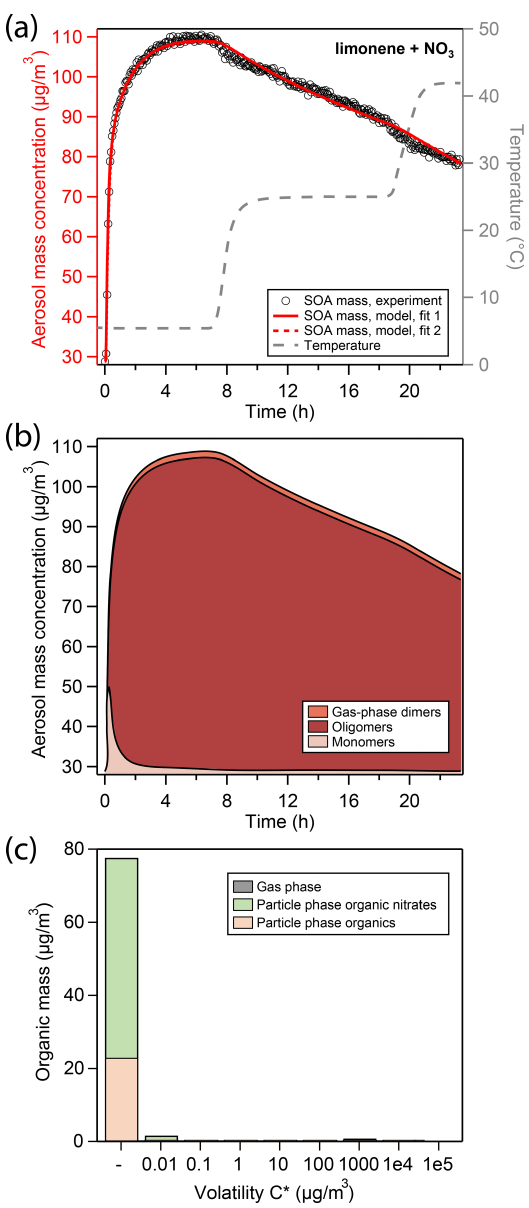
Figure 2. (a) Comparison of experimental and modeling results for oxidation of limonene with NO 3 . Open black markers are experi- mental aerosol mass obtained using an SMPS. The red solid line represents the best-fit model result, the red dotted line represents an alternative model fit, and the grey dashed line corresponds to the experimental temperature profile. (b) Analysis of the oligomeriza- tion state of particle-phase products in the model according to fit 1. (c) Analysis of the occupation of volatility bins of all products according to fit 1 and at peak SOA mass. Shadings in the bar plot denote where molecules of a certain volatility bin reside: gas phase (grey) or particle phase (colored). Products in the particle phase are further distinguished as organic nitrates (green) and non-nitrated or- ganics